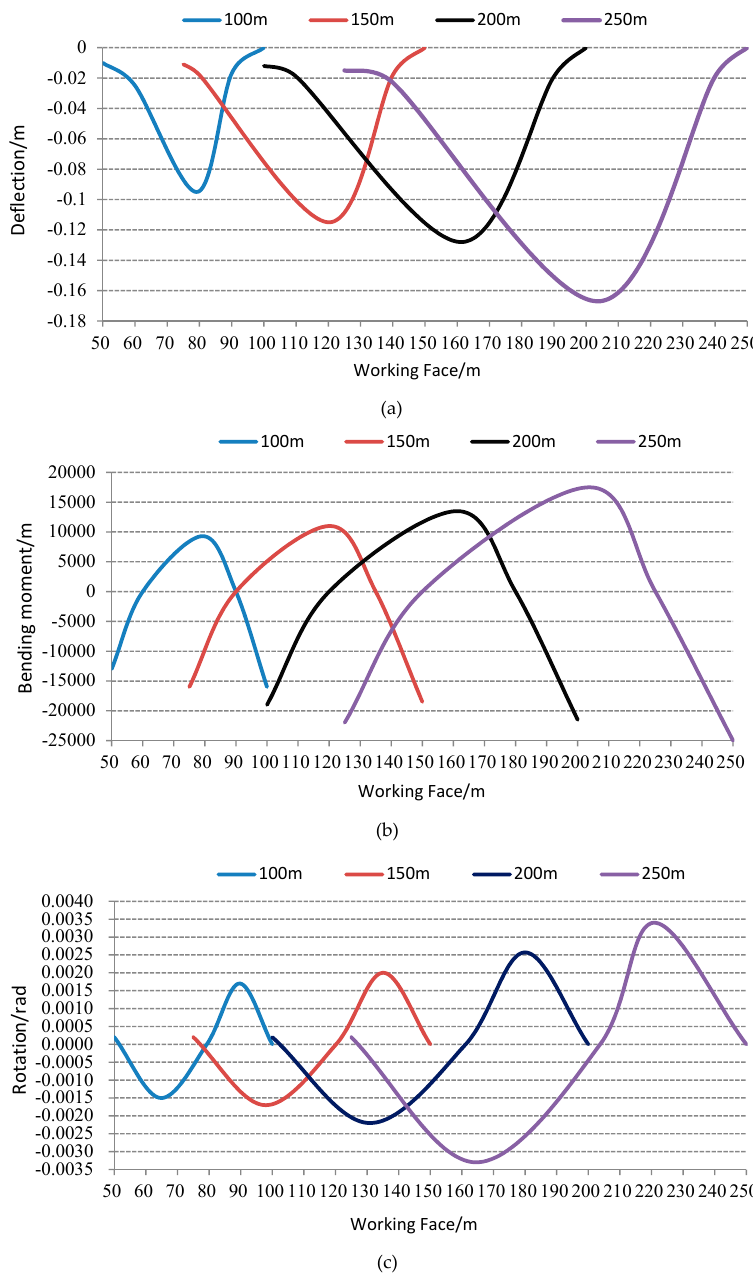
Figure 7. Roof deformation and internal force under different working face lengths: ( a ) Deflection; ( b ) bending moment; and ( c ) rotation.